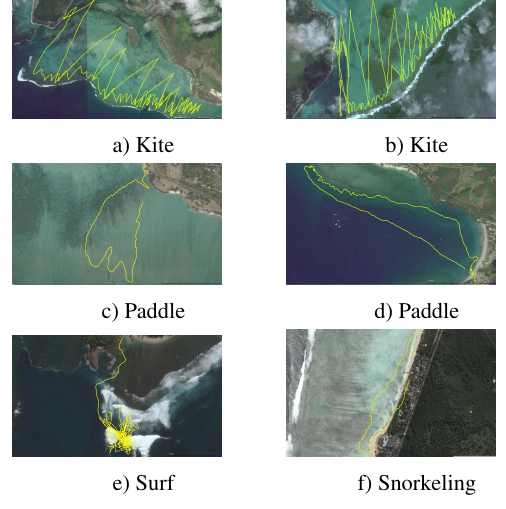
Figure 3. Different types of survey trajectories according to the gears